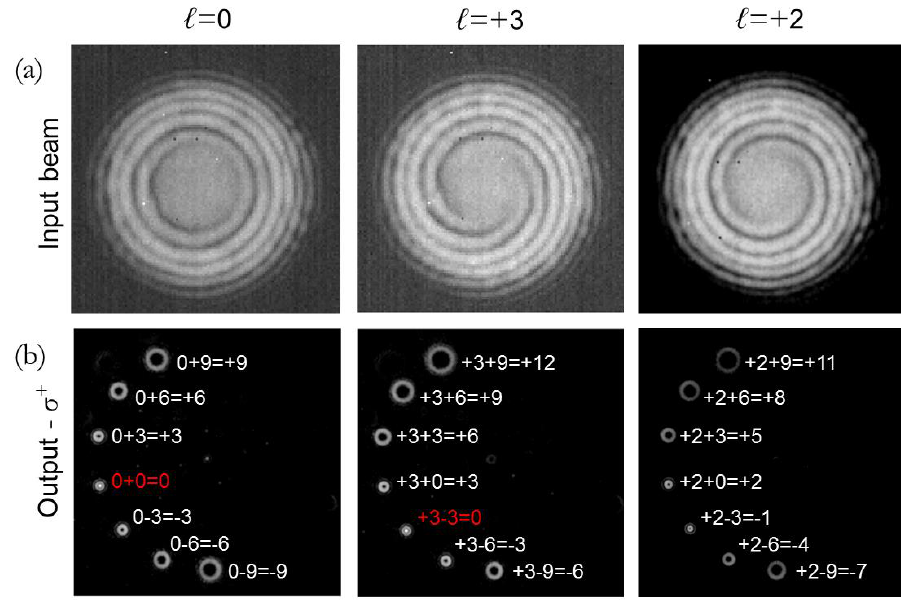
Figure A1. ( a ) Interference patterns of the OAM beams exploited for the sorter characterization, for ℓ = 0, +2, +3. The number and twist-handedness of the spirals is indicative of the carried OAM. ( b ) Output of the fabricated OAM for input right-handed circular polarization states. A bright spot appears when the azimuthal index of the generated far-field optical vortex is equal to zero. If the input beam carries an OAM value which is not included in the sorter set, as in the case of ℓ = +2, no peak appears in far-field.